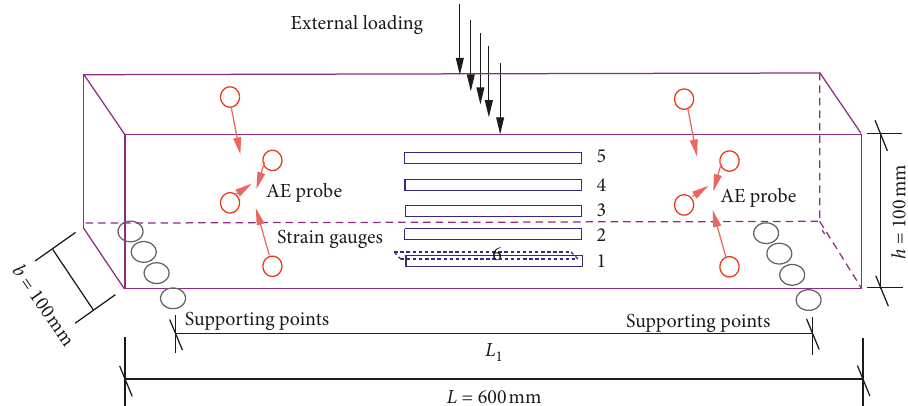
Figure 4: Three-point bending loading configuration and strain gauge